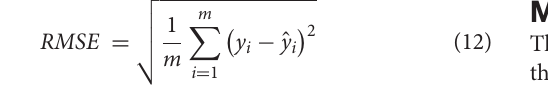
ratio of the sum of the squares of the deviation between the predicted value and the actual value and the ratio of the number of predictions m , which is used to measure the deviation between the predicted value and the real value, as shown in Equation 12. The R 2 is used to evaluate the degree of agreement between the predicted value and the true value in the regression model. The numerator part represents the sum of the squared differences between the true and predicted values. The denominator part represents the sum of the squared differences between the true value and the mean of the true value, as in Equation 13. The error formula is shown in Equation